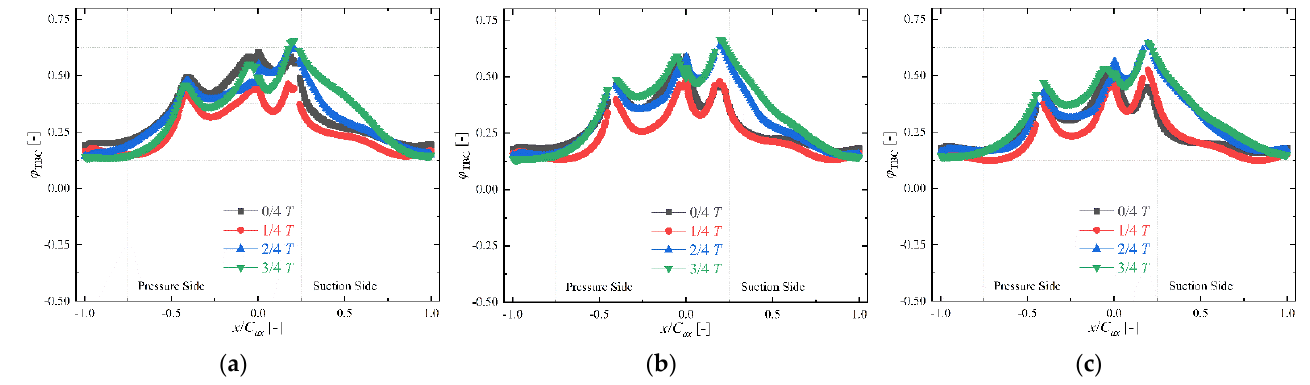
Figure 15. The cooling effectiveness distribution along the substrate metal surface. ( a ) At 25% span; ( b ) at 50% span; ( c ) at 75% span.